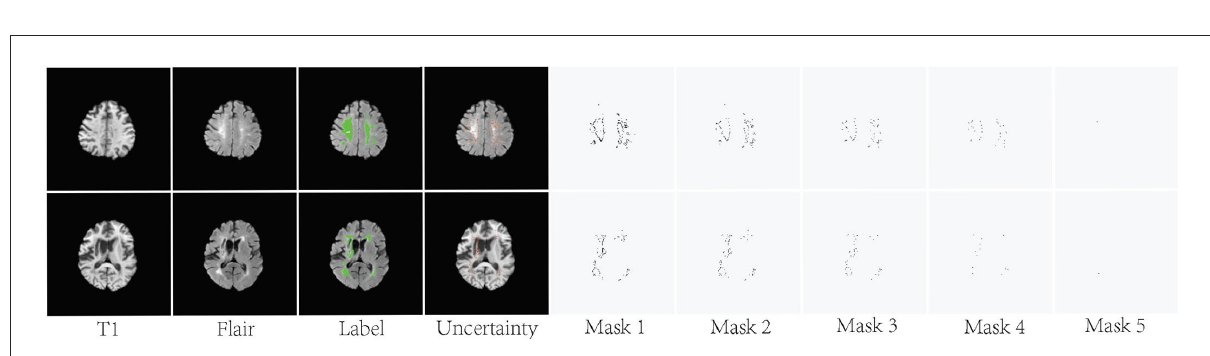
FIGURE4 Visualization of the uncertainty maps and generated binary masks on two training slices. The green areas indicate ground truth.